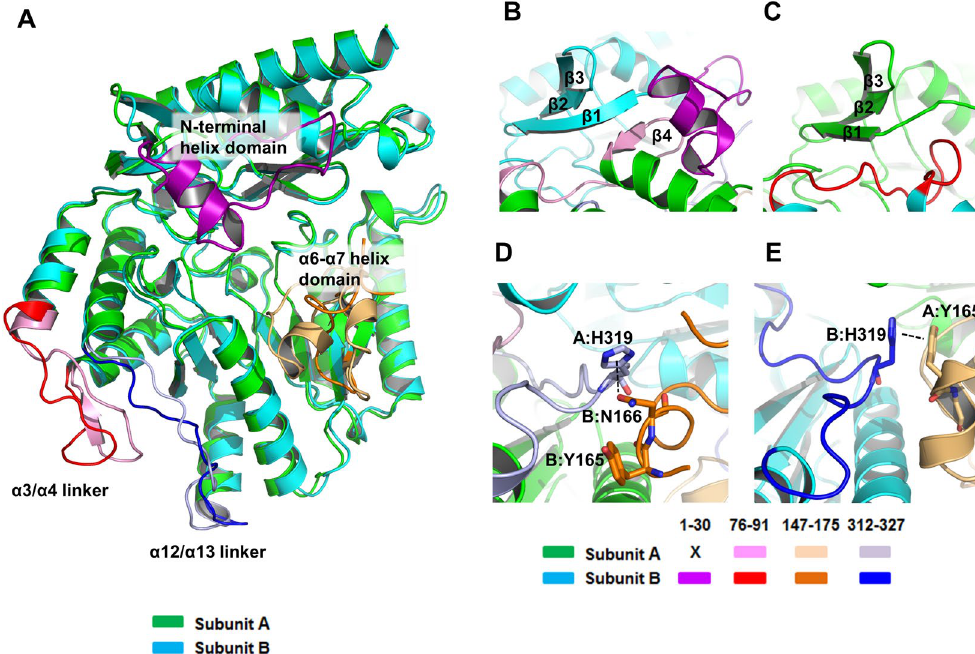
Figure 5. Comparison of subunit A and B in apo Vfat. ( A ) Superimposition of the structures of subunit A (green) and B (cyan) of apo Vfat revealed that α 3/ α 4 linker loop (pink for subunit A and red for subunit B) and α 12/ α 13 linker loop (light blue for subunit A and blue for subunit B) have significantly different conformations. The N-terminal helix domain (purple for subunit B) was disordered in subunit ( A ) In contrast to N-terminal helix domain, the α 6- α 7 helix domain was disordered in subunit B (light orange for subunit A and orange for subunit B). ( B , C ) Close-up presentation of the dimer interface in the vicinity of the α 3/ α 4 linker loop from subunit A (pink color) ( B ) and B (red color) ( C ). The pink arrow indicates the β 4 strand from subunit ( A ) In the N-terminal β 1,2,3 sheet region, subunit A (green) was more wide than that of subunit B (cyan). ( D ) Interaction between H319 in subunit A and N166 in subunit. ( B ) The imidazole ring of H319 interacts with the delta oxygen on N166 in subunit B through an aromatic n → π * interaction. The α 6/ α 7 helix from subunit B is colored orange. ( E ) Interaction between Y165 from subunit A and H319 from subunit B through π -stacking interactions.